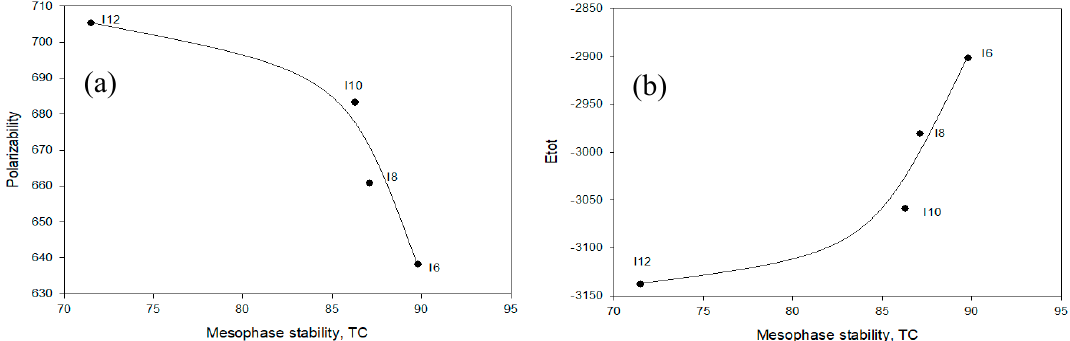
Figure 8. The relationship of the akoxy chain-length / mesophase stability of 1:1 complex A n / II 16 against ( a ) the calculated polarizability and ( b ) the total predicted E tot .